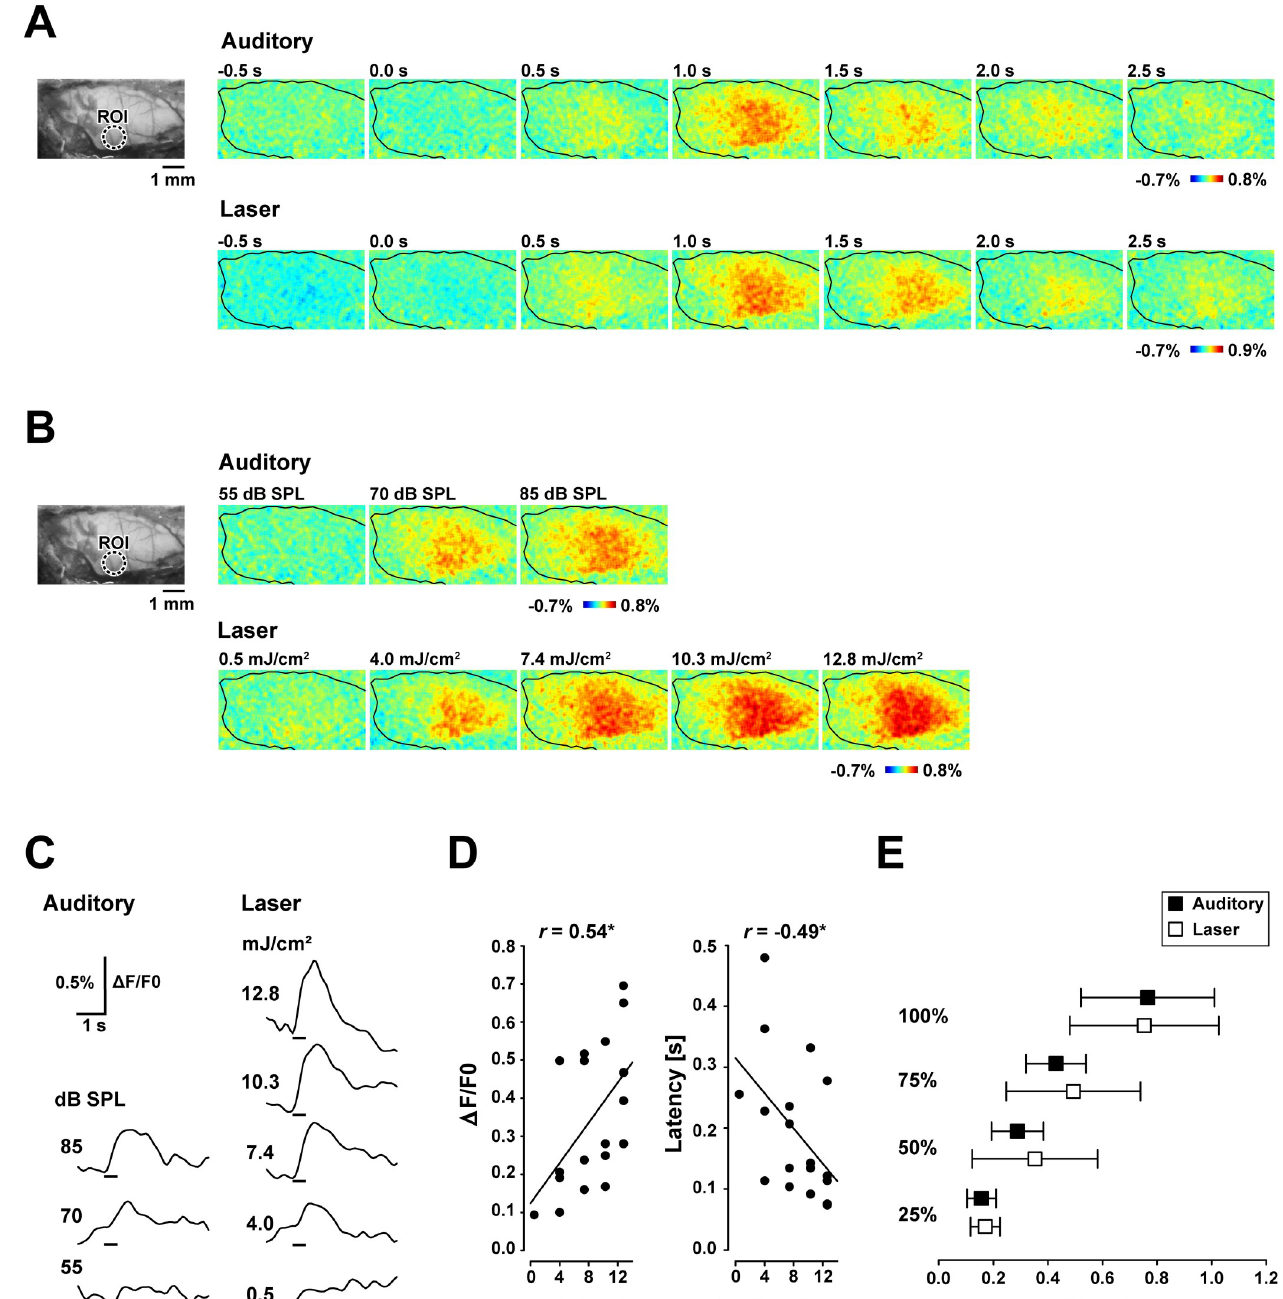
Fig 3. Auditory- and laser-evoked flavoprotein responses in the temporal cortex. (A) Original fluorescence image (left) and flavoprotein responses evoked by auditory (85 dB SPL) and laser (7.4 mJ/cm 2 ) stimuli (right). The circular window shows the region of interest (ROI) centered on the maximum responses of all recordings. The recording areas are indicated with black lines. (B) Original fluorescence image and changes in intensity-dependent responses to auditory (55–85 dB SPL) and laser (0.5–12.8 mJ/cm 2 ) stimuli. (C) Time-course of the fluorescence changes in the ROI following acoustic (55–85 dB SPL) and laser (0.5– 12.8 mJ/cm 2 ) stimuli. The vertical bars on the bottom represent the stimulus period. (D) Changes in response amplitude and response latency following infrared laser stimulation of various radiant energy ( n = 6). (E) Latencies to the 25%, 50%, 75% and 100% maximum response to laser (7.4 mJ/cm 2 ) and equivalent auditory stimuli ( n = 12). Error bars indicate the standard